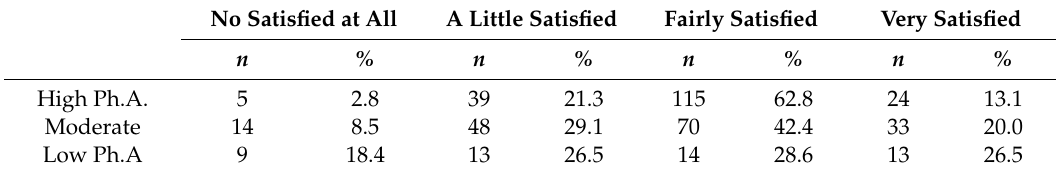
Table 5. Frequencies of the subjective health scale (CUBRECAVI) according to level of physical activity. No Satisfied at All A Little Satisfied Fairly Satisfied Very Satisfied n % n % n % n % High Ph.A. 5 2.8 39 21.3 115 62.8 24 13.1 Moderate 14 8.5 48 29.1 70 42.4 33 20.0 Low Ph.A 9 18.4 13 26.5 14 28.6 13 26.5 n = number of participants; % =